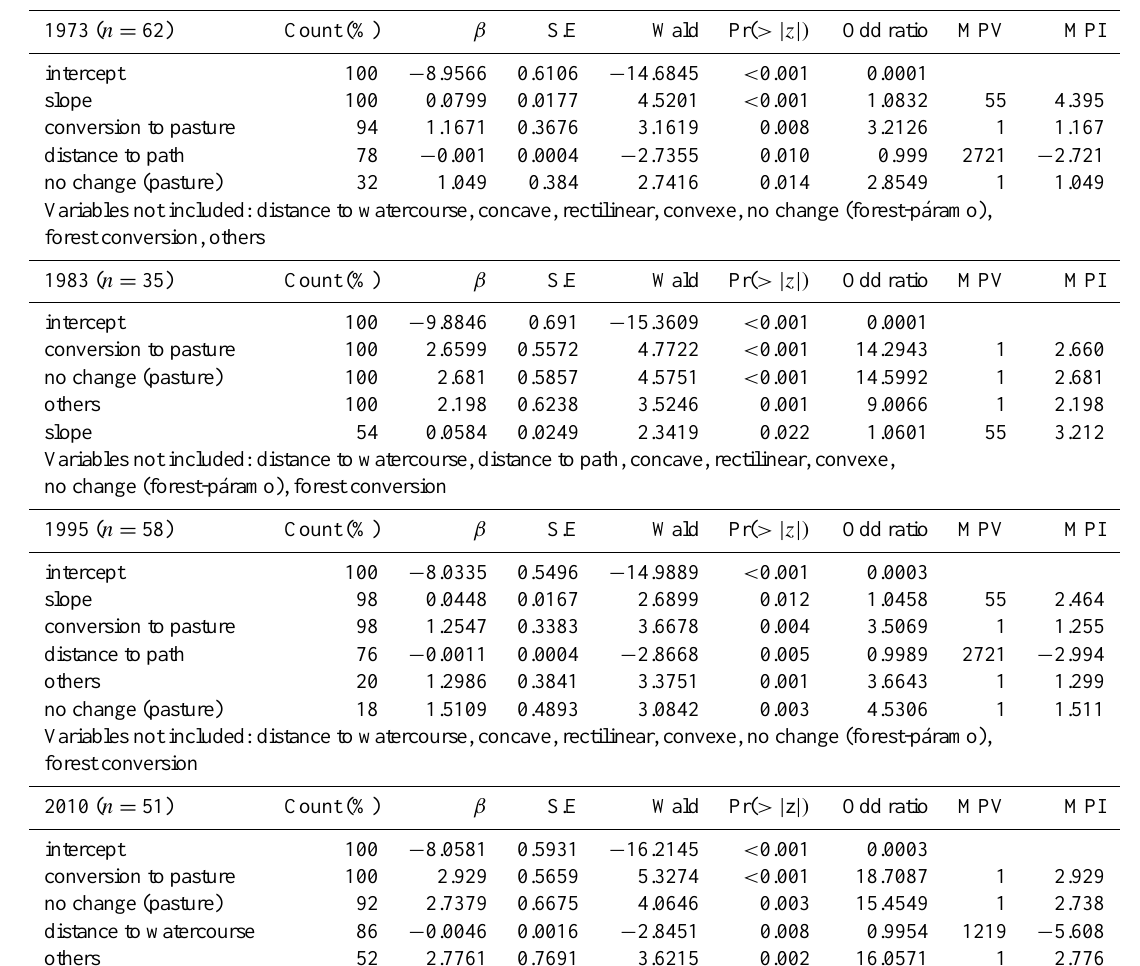
Table 4. Summary of the rare event logistic regression with replications showing, for every year, percentage of replications in which the variable entered (count), logistic coefficient ( β) and its standard error (S.E), Wald statistic, variable significance (Pr( > | z | ) ), Odd